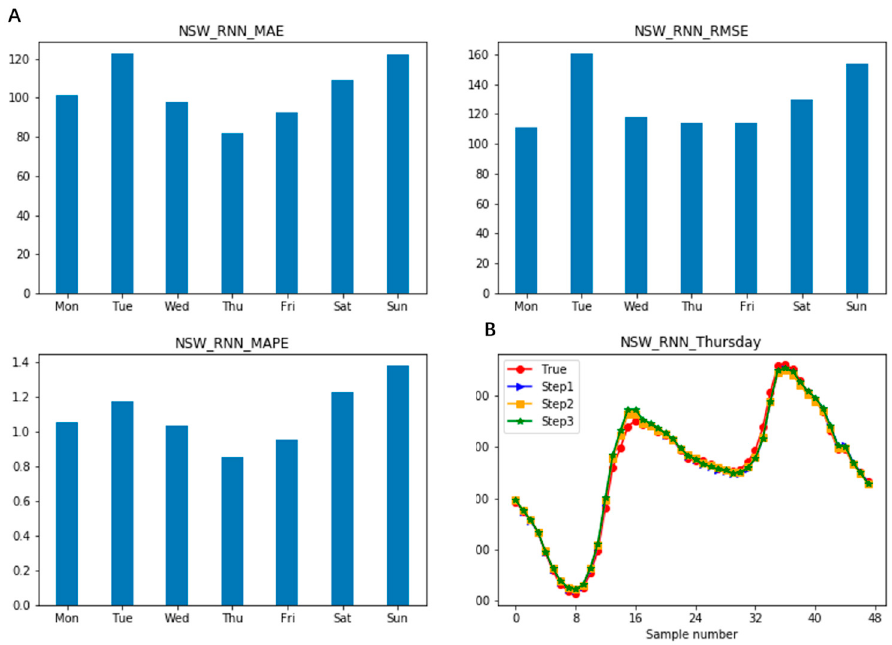
Figure 4. Comparison of the 1-step, 2-step, and 3-step forecasting results of RNN on Thursday. ( A ): three evaluation metrics results of RNN ( B ): RNN forecasting results on Thursday.